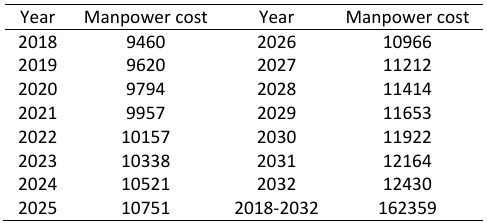
Table 7: Projected the manpower cost for SWCTT in different district of Tehran from 2018 ‐ 2032 (thousand US dollars)